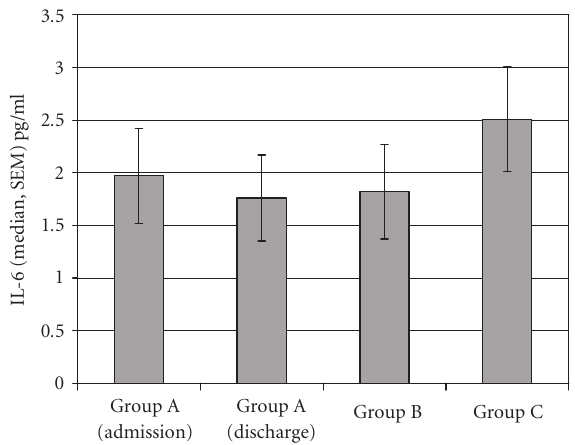
Figure 3: Serum levels (median, SEM) of IL-6 in the three study